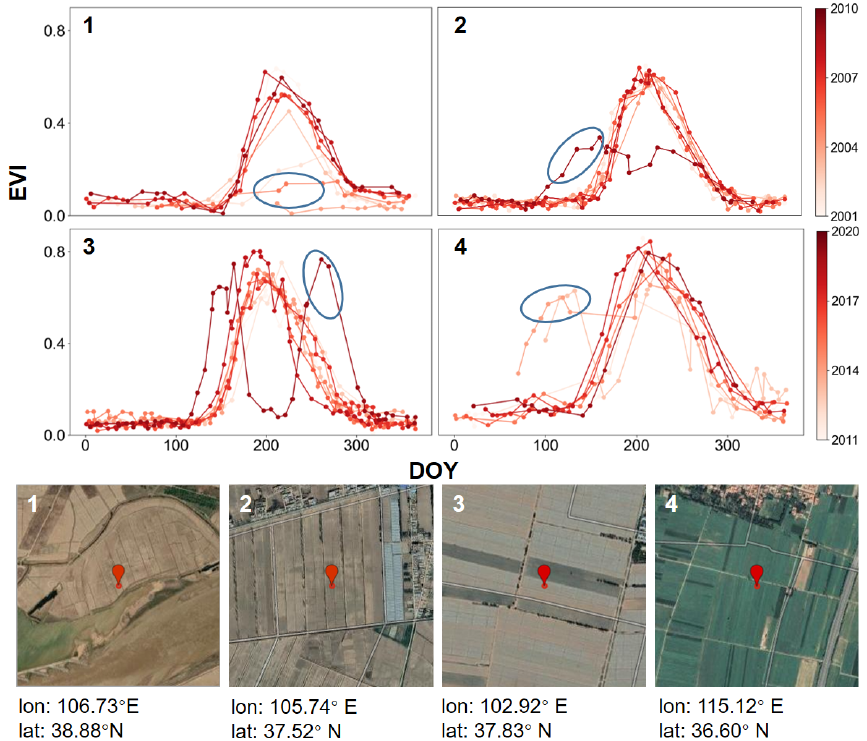
Figure 9. Cases with a significant change in crop planting patterns. The blue ellipses indicate identified anomalies of EVI observations. We can note that the red dots are all located in the plots from the © Google Earth